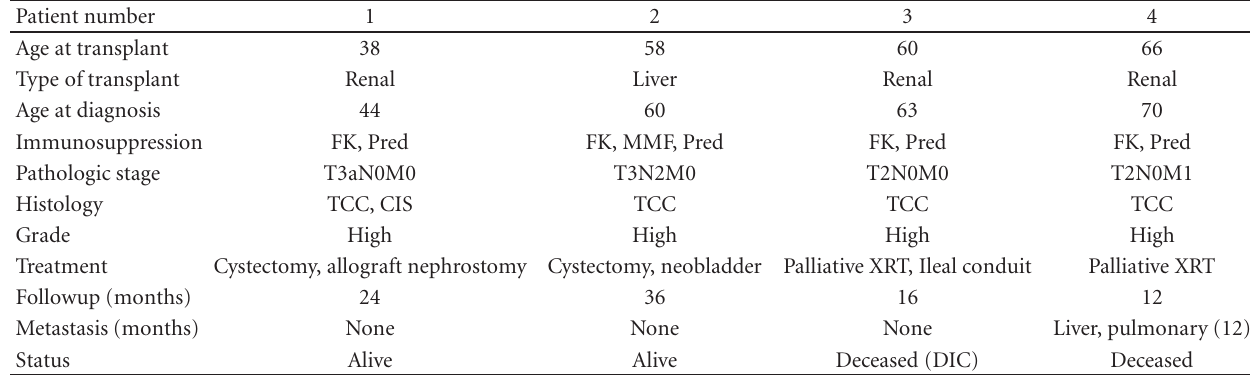
Table 2: Characteristics of patients with muscle-invasive TCC of the